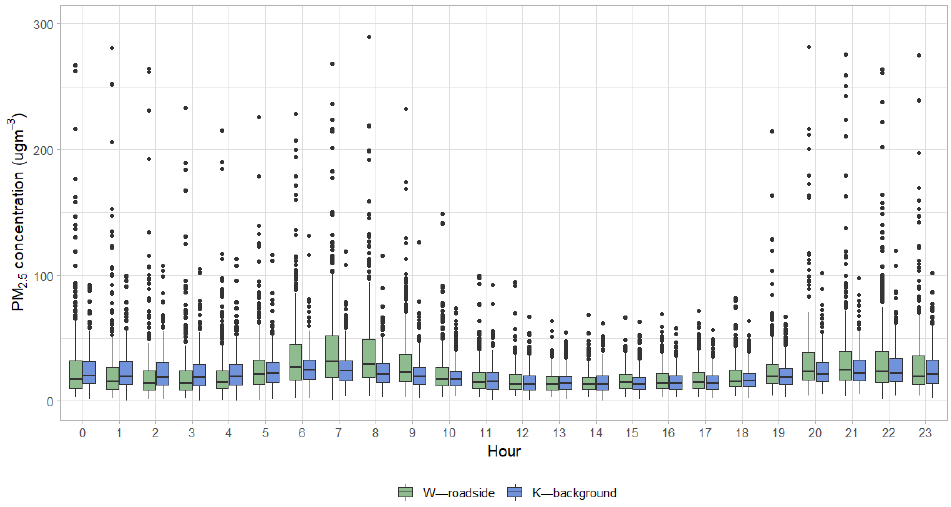
Figure 5. Particulate matter hourly variability from 10 March to 30 May 2016–2019. 3.2. Comparing the Air Quality between Roadside and Non-Roadside Stations in First COVID-19 Pandemic